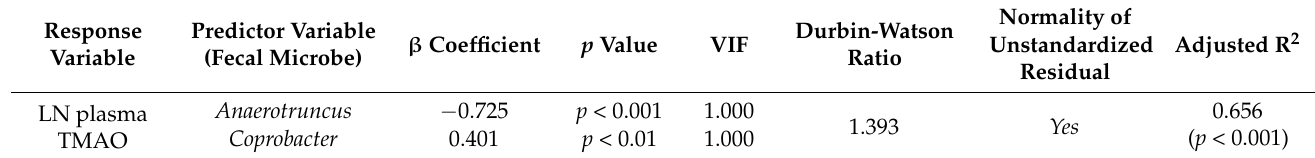
Table 2. Best predictors of variations in plasma TMAO levels from stepwise forward regression analysis.